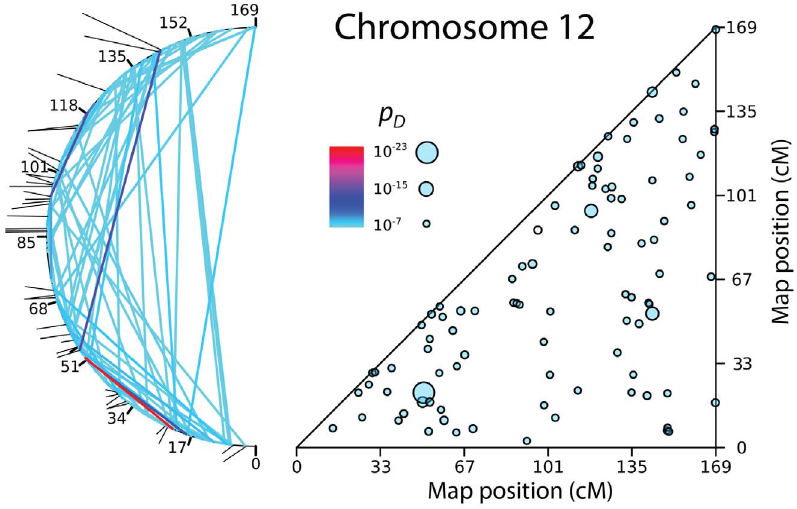
Figure 4. Patches of LRLD on Chromosome 12.